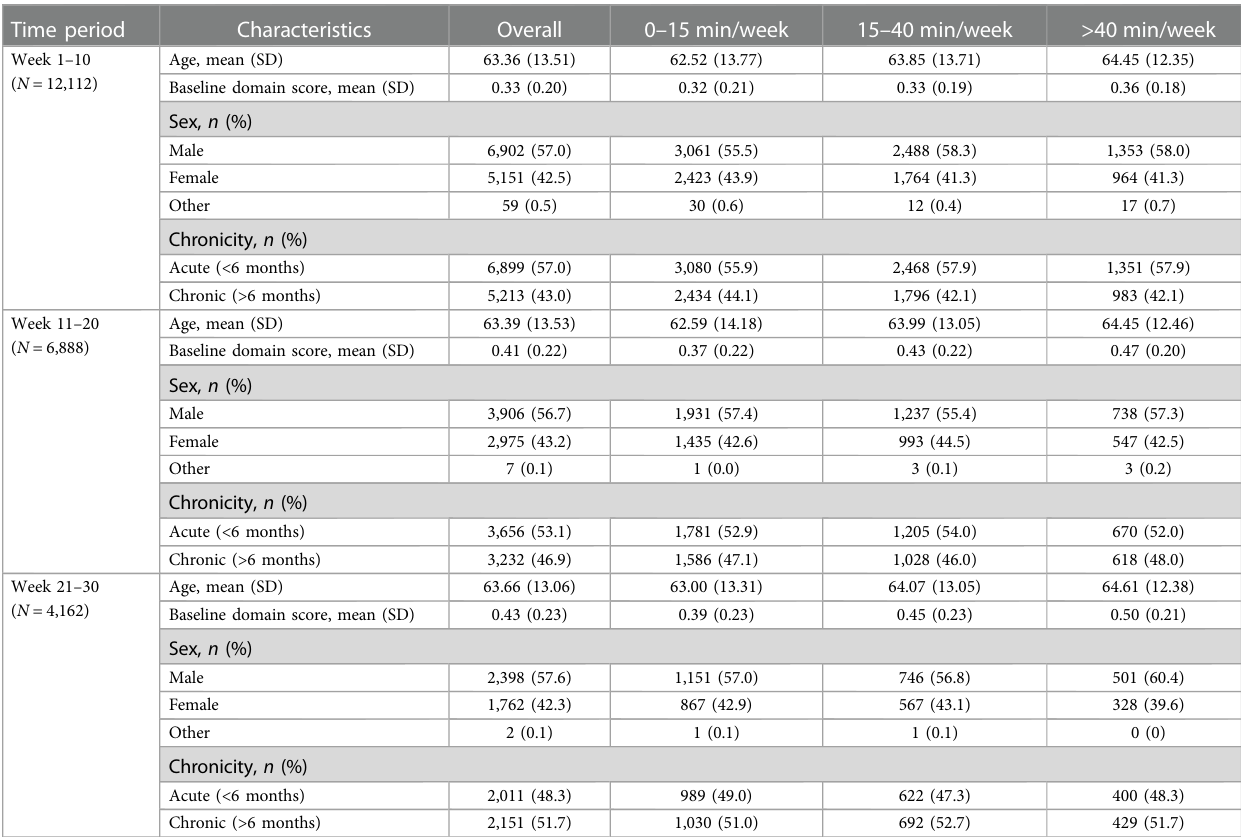
TABLE 5 Summary statistics of the variable cohort.